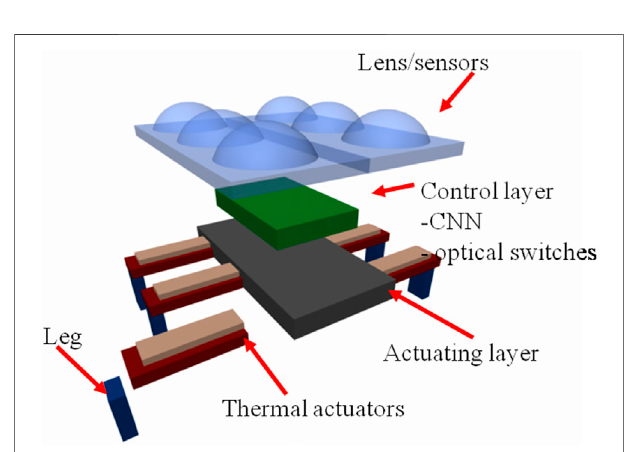
FIGURE 12 | Schematic representation of a nanorobot based on piezoelectric materials for the actuation of the legs. The control system is based on a CPG implemented via a CNN chip. The top layer provides both a medium for harvesting solar energy and for collecting sensorial stimuli.